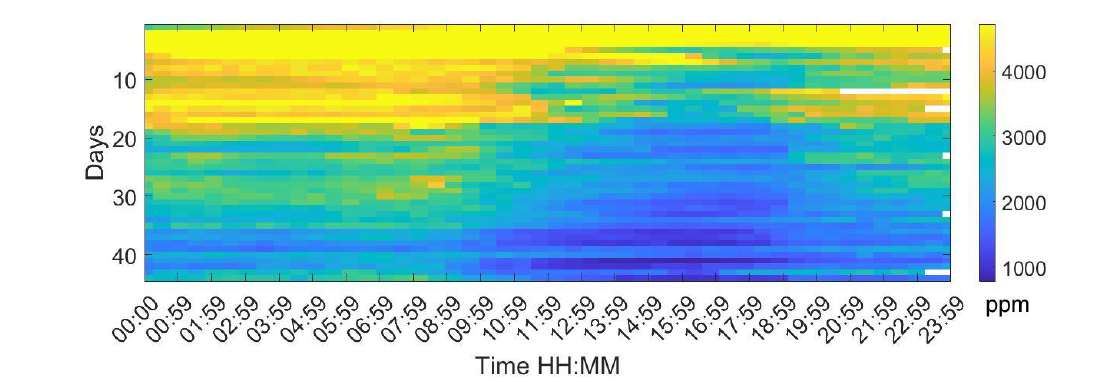
Figure 9. Map of the mean CO 2 values for each day of the campaign. The horizontal axis shows the hours of the day and night, displaying a value every 30 min, and the vertical axis shows the days of the cycle.